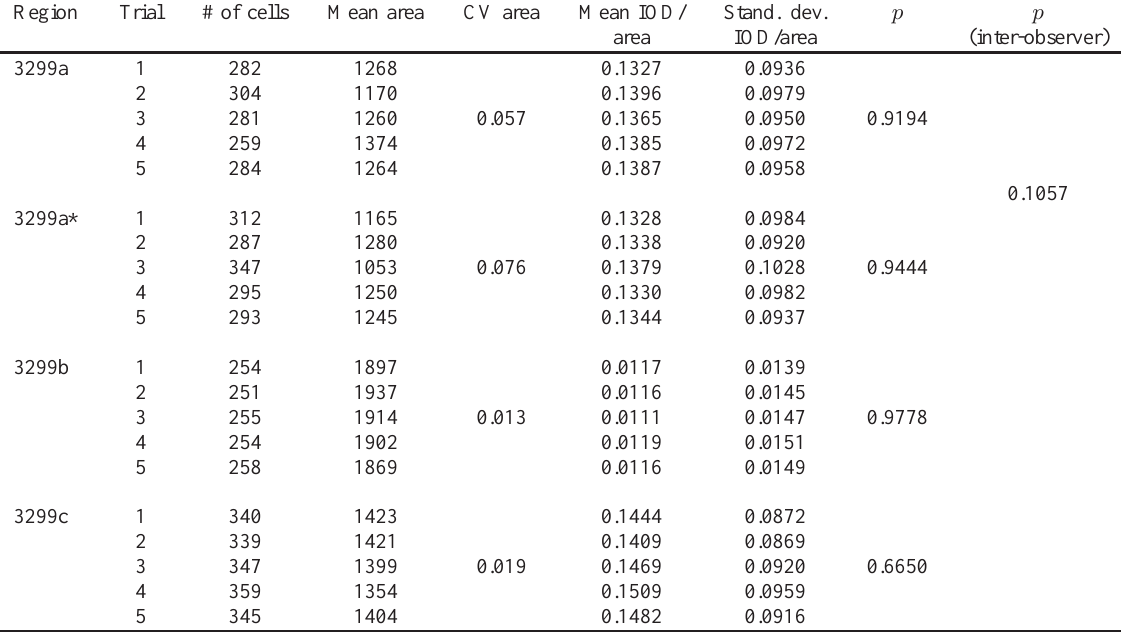
Table 2 Reproducibility measurements performed on DCIS components of a primary breast carcinoma. Of each ROI, the number of cells, mean polygon area, mean IOD/area and standard deviation of IOD/area are listed. Intra-observer c.v. is shown for each area. p values from one-way ANOVA performed on five repeated measurements on each of three separate regions within the slide indicated that no significant differences between distributions of area normalised IOD (IOD/area) existed. A single region (denoted 3299a and 3299a ∗ ) was measured by two independent observers, who were also tested and